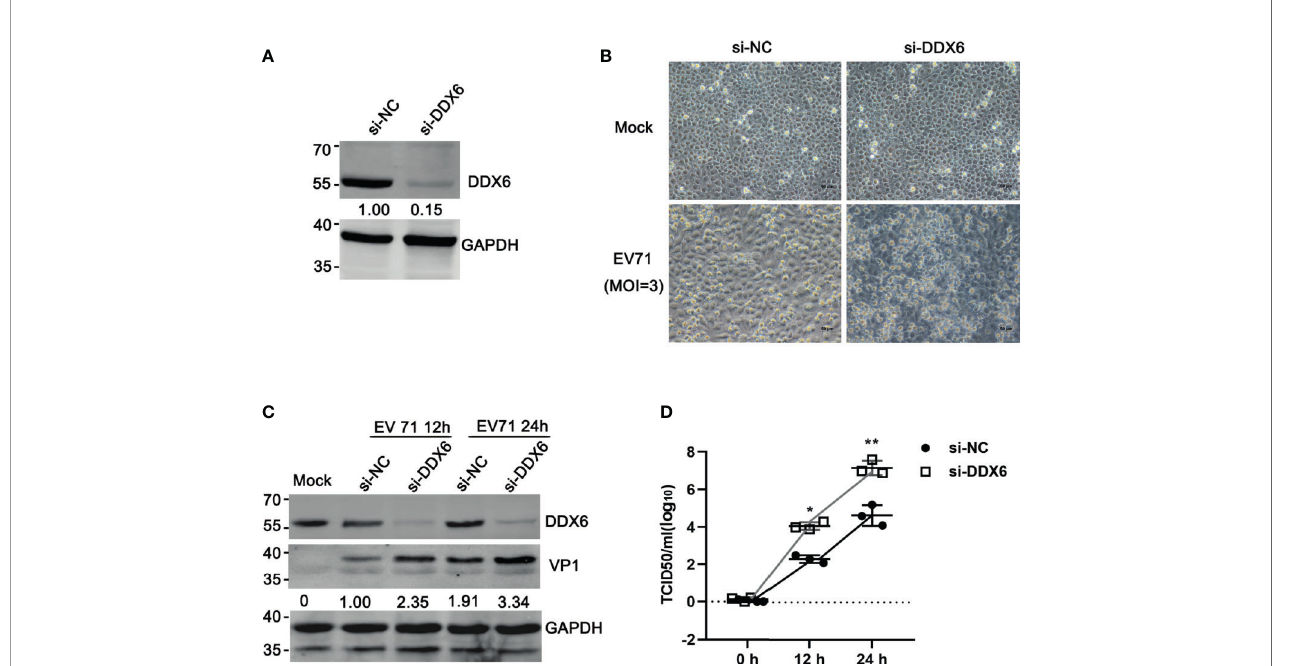
FIGURE 2 | Knocking down DDX6 facilitated EV71 replication. (A) Ef fi ciency of DDX6 downregulation by si-DDX6 in HeLa cells. HeLa cells were treated with either si-NC (a scrambled sequence) or si-DDX6. The total protein extract from infected cells was analyzed by Western blot using antibodies against DDX6 and GAPDH (loading control). (B) Cells transfected with either si-NC or si-DDX6 grown in 12-well plates were infected with EV71 (MOI =3) for 36 h. The EV71-induced CPE in the DDX6 +/+ and DDX6 -/- cells were photographed using microscopy (scale bar: 50 µm). (C) After si-NC or si-DDX6 transfection for 36 h, the relative VP1 expression of HeLa cells 12 or 24 hpi was shown, respectively. Densitometry was performed, and lane 2 is set as 1.00. (D) Analysis of progeny virus in culture supernatants by a standard plaque assay. The values shown are the means ± SD of three determinations (* P < 0.05, ** P <